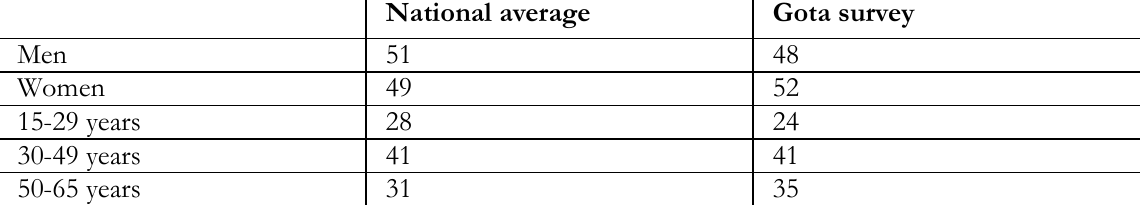
Table 1: Response rates due to gender and age compared to the national average in the total group of 15-65 years old (per cent) National average Gota survey Men 51 48 Women 49 52 15-29 years 28 24 30-49 years 41 41 50-65 years 31